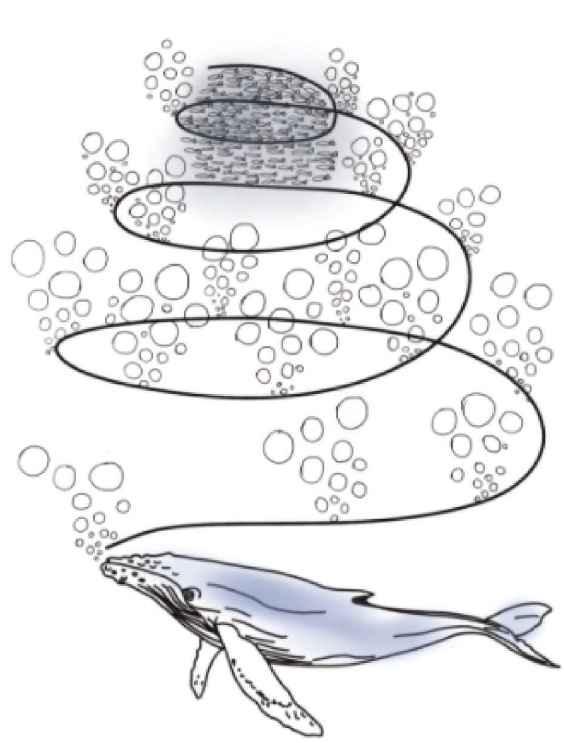
Figure 1: Unique bubble-net feeding method and spiral moment for updating the position of humpback